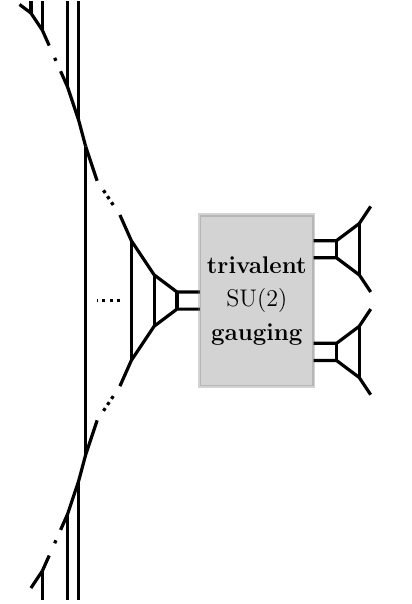
Figure 6 . A web-like diagram which is obtained by rotating web in (cid:12)gure 5 by (cid:25)